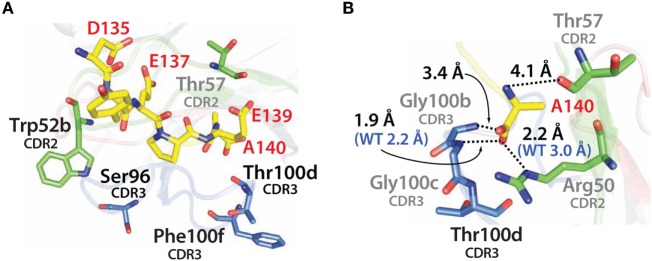
Analysis of the contributions of the acquired mutations in the N2.17 VHH antibody to enhanced affinity using computational models of the antibody–antigen complex. (A) Model of the N2.17 VHH in complex with the α-synuclein peptide. The four acquired CDR mutations are highlighted in black text. No CDR mutations make direct contact with the antigen. (B) New or enhanced interactions between the N2.17 VHH and the α-synuclein peptide. The labeling is the same as in Figure 11.